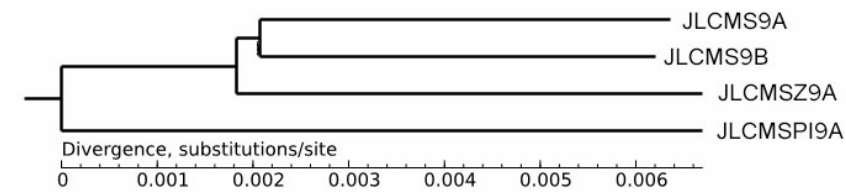
Figure 7. Phylogenetic tree of three cytoplasmic male sterility lines and the maintainer line constructed using the re-sequencing data.